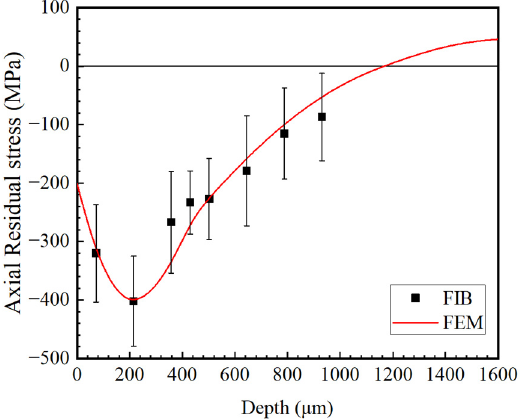
Figure 4. Axial residual stress distribution of case-carburized solid specimen. Bars on top indicate the standard deviation.